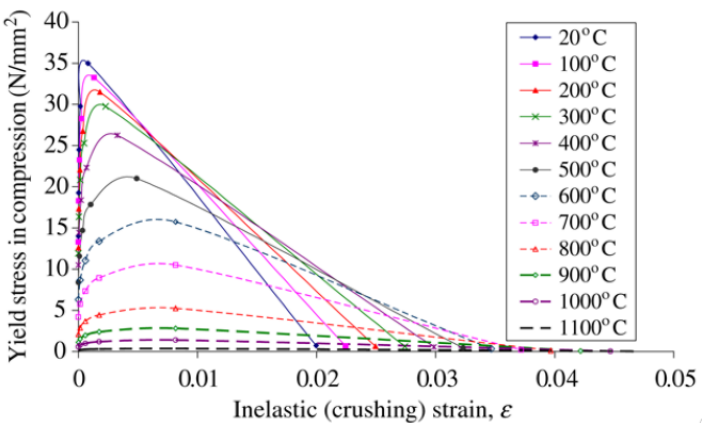
Figure 8. Tensile stress-strain relationship at elevated temperature for concrete, EC2 British Stand- ards Institution.